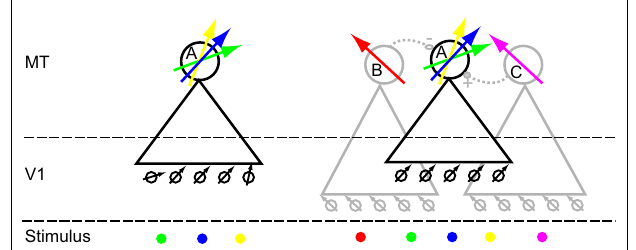
FIGURE 13 | Cartoon models of two mechanisms that could underlie the in homogeneities we observed. Large circles represent MT neurons, labeled (A,B and C).Triangles represent their receptive field. Neuron A is the neuron whose responses we are trying to understand.The arrows represent the preferred direction for single moving dots. Small circles representV1 neurons; black and gray arrows their preferred direction. At the “Stimulus” level, each colored dot corresponds to a particular location on the screen.The preferred direction arrow corresponding to that location is colored correspondingly. Lateral connectivity (dashed lines) between MT neurons can be excitatory (solid circle, + ) or inhibitory (open circle, − ). On the left is a model in which directional inhomogeneities arise through judicious sampling from theV1 population; we call this the afferent model. On the right is a model in which lateral interactions within MT create complex directional inhomogeneities; we call this the lateral model. See main text for a full